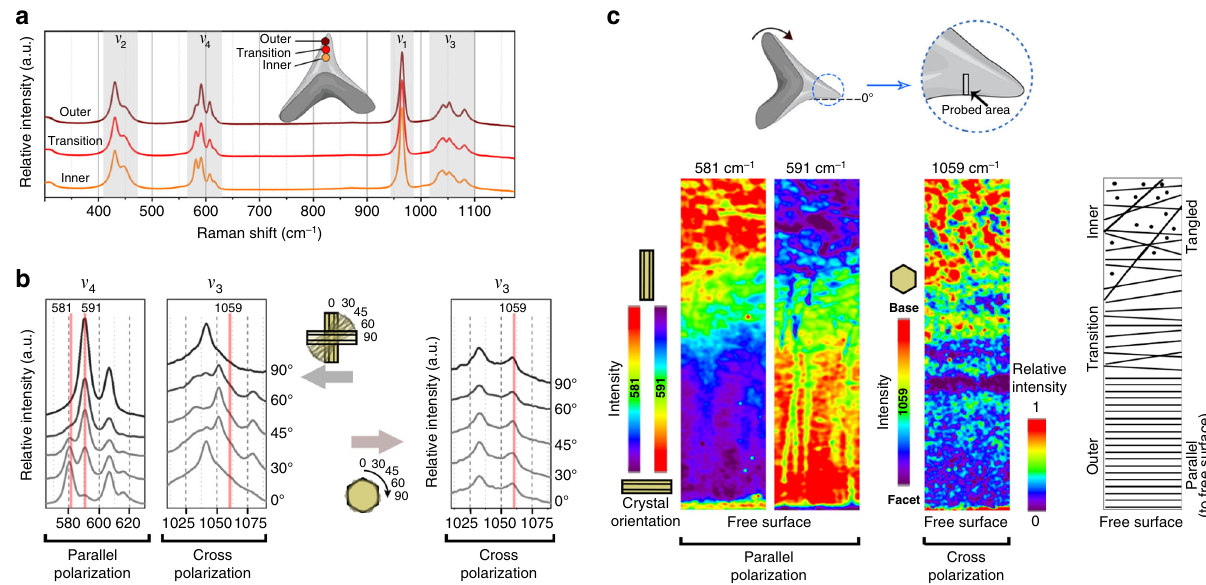
Fig. 4 Raman analysis of the enameloid demonstrating the graded microarchitecture of the FAP crystallites. a Raman spectra pro fi les of enameloid regions (the color-coded spots marked on the tooth image), underlining that the enameloid is homogeneously crystalline fl uorapatite in composition. The change in the relative intensity of vibrational band peaks ν 4 (581 cm − 1 , 591 cm − 1 ) and ν 3 (1033 cm − 1 , 1041 cm − 1 ), denoting variation in FAP crystallite alignment in different regions. b Polarized Raman spectroscopy study of a geological FAP monocrystal, used to calibrate the relationship between crystal orientation and peak intensity for ν 3 and ν 4 vibrational bands. Extracted spectra reveal that the relative intensities of the 581 cm − 1 and 591 cm − 1 peaks, as well as the presence of the 1059 cm − 1 peak in cross-polarized measurements indicate the crystallographic orientations of the FAP crystals. c Collected Raman maps using parallel polarization and cross-polarization acquired in the rectangular ROI indicated in the schematic image at the top of the panel (scanning area of 50 μ m × 194 μ m). The maps were fi ltered for the orientation-sensitive peaks shown in c (581 cm − 1 , 591 cm − 1 , 1059 cm − 1 ) to illustrate local variation in the relative peak intensity. By calibrating the collected maps from the enameloid according to the extracted spectra from the geological FAP ( b and Supplementary Fig. 5), the orientations of FAP crystallites in different enameloid layers were quanti fi ed. As illustrated by the schematic image on the right of the panel, the parallel-aligned FAP crystallites at the free surface of the outer enameloid gradually transition to a tangled organization in the inner − 1 , 1041 cm − 1 ), suggesting differences in the c -axis ν 3 : 1033 cm